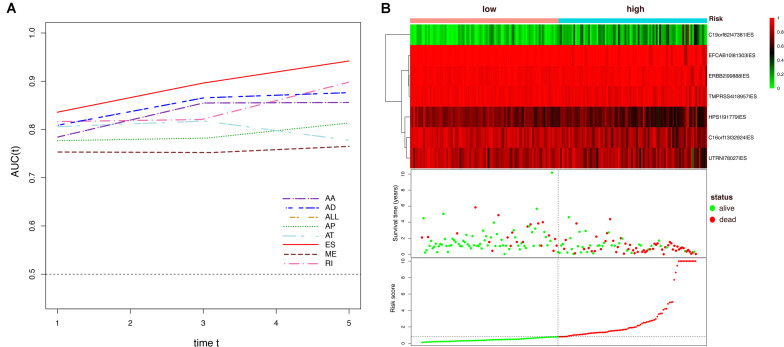
Dynamic AUC values of ROC curves for each AS model and determination of the ES prognostic signature in the ESCA cohort. (A) The curves of time-dependent AUCs versus time (1–5 years) of each signature: AUC(t) versus t
(B) Patients were divided into high- and low-risk subgroups based on the median of risk scores based on the ES prognostic predictor. The upper part is the heatmap of AS events involved in the prognostic predictor, color transition from green to red indicates the increasing PSI score of corresponding AS event from low to high. The middle part is the survival status and survival time of each individual. Color of each plot represents the survival status of each patient. The bottom part is risk score of each individual.